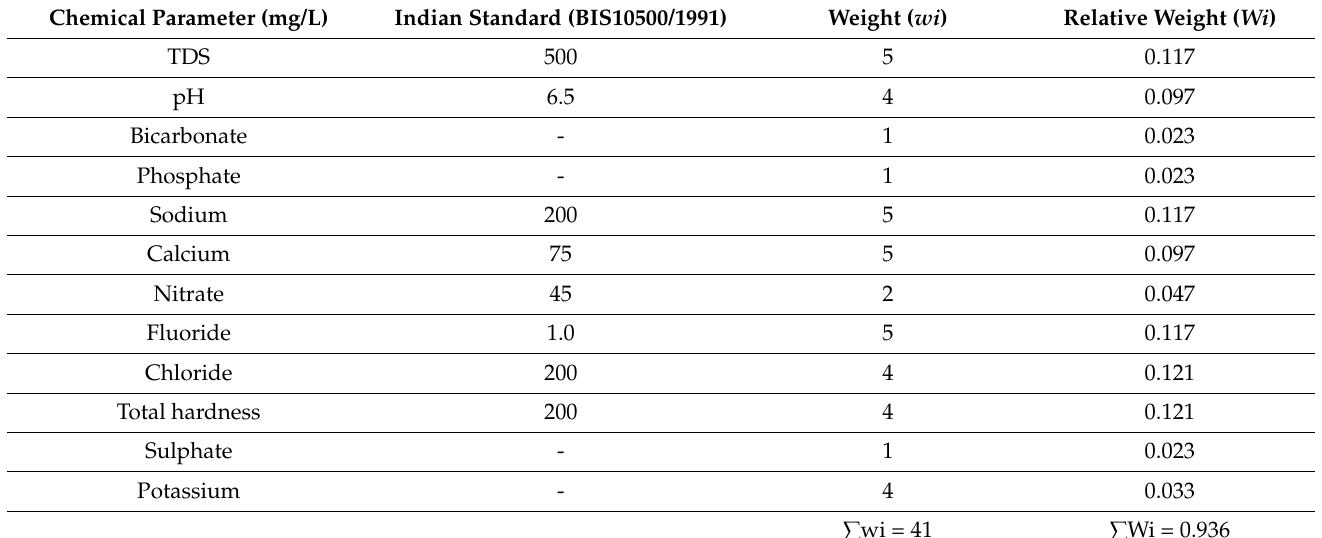
Table 2. Relative weight of chemical parameters.